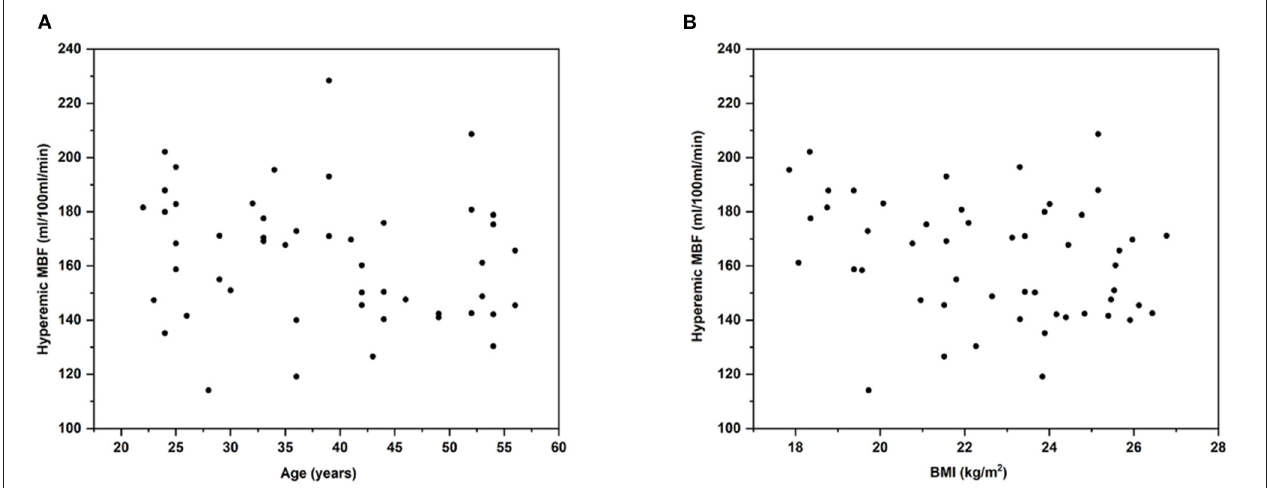
FIGURE 3 | Age and BMI vs. hyperemic MBF in healthy volunteers. Pearson correlation analysis of age and BMI vs. hyperemic MBF. Scatterplot shows the relationship between (A) age and hyperemic MBF (y = 181.76 - 0.468x; r = − 0.22; R 2 = 0.048; P = 0.1242) and (B) BMI and hyperemic MBF (y = 214.78 - 2.300x; r = − 0.27; R 2 = 0.072; P = 0.0570). This study could not demonstrate significant relationship between age, BMI and hyperemic MBF. BMI, body mass index; MBF, myocardial blood flow.